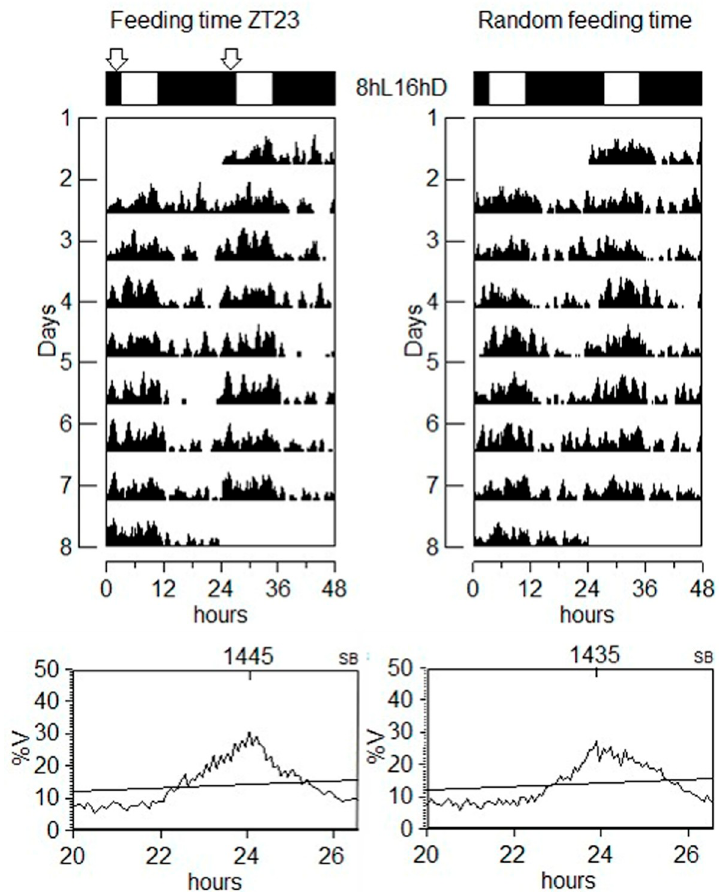
Fig 7. Diurnal locomotor activity from turbot under short photoperiod (SP). Recording activity during 8 days is represented by double plot of two consecutive days and represented by actograms. The white and black bars above the actograms indicate light and dark periods. The arrows above the white bar indicate the time where food is delivered. Fish were kept in SP and fed at the end of the scotophase (ZT23) (left), or randomly fed during the light phase (right). Fish showed rhythmic activity in